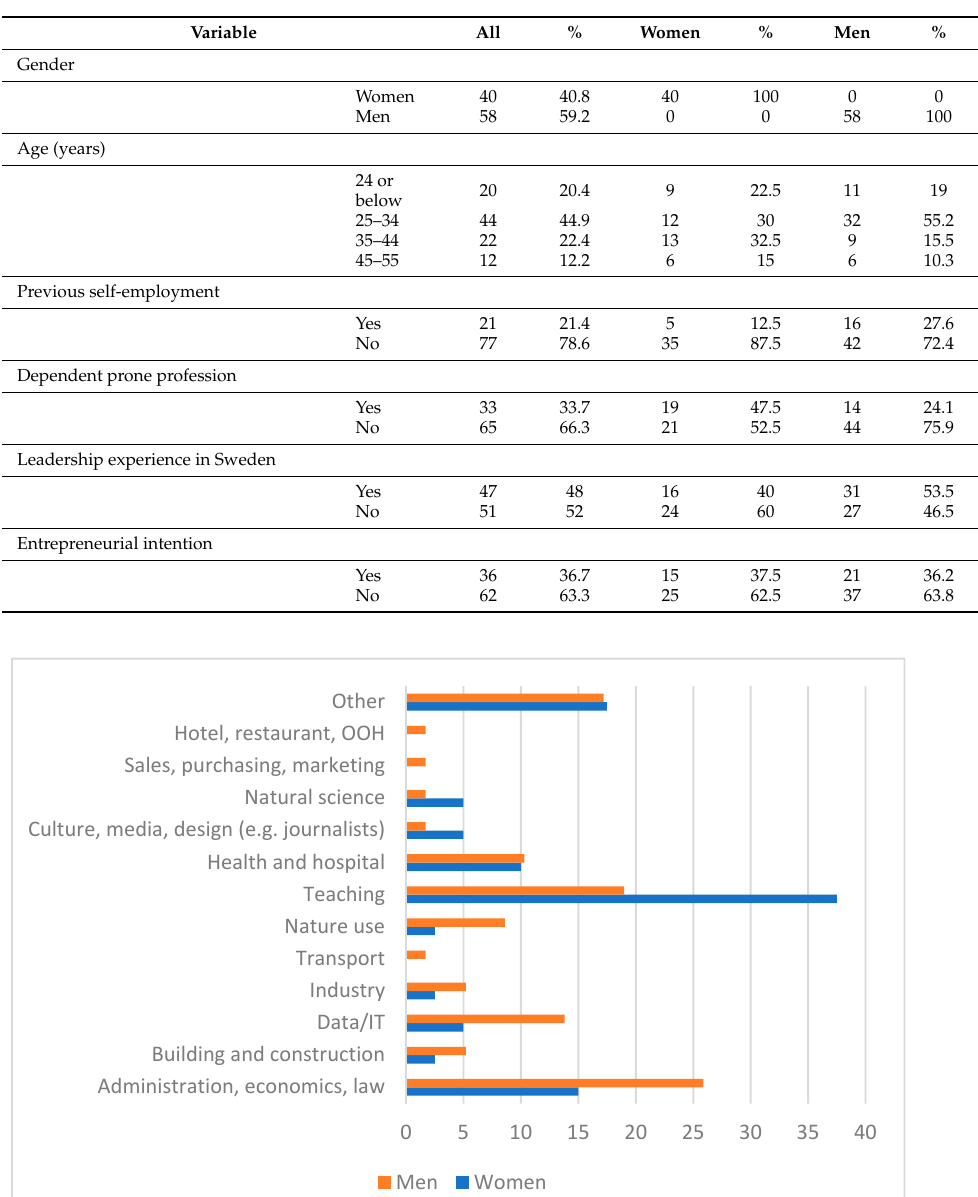
Table 1. Descriptive statistics. Predictor variables and outcome variable based on the sample ( N = 98) of highly-skilled respondents with refugee experience.